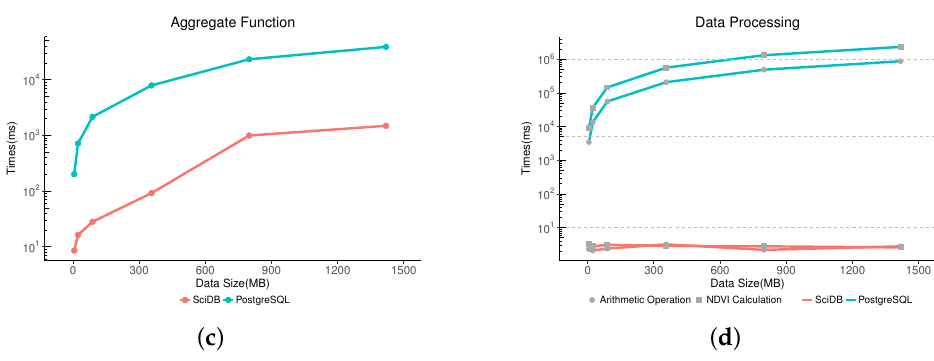
Figure 5. Performance comparison between SciDB and PostgreSQL. ( a ) Data import; ( b ) Data query; ( c ) Aggregate function; ( d ) Data processing.